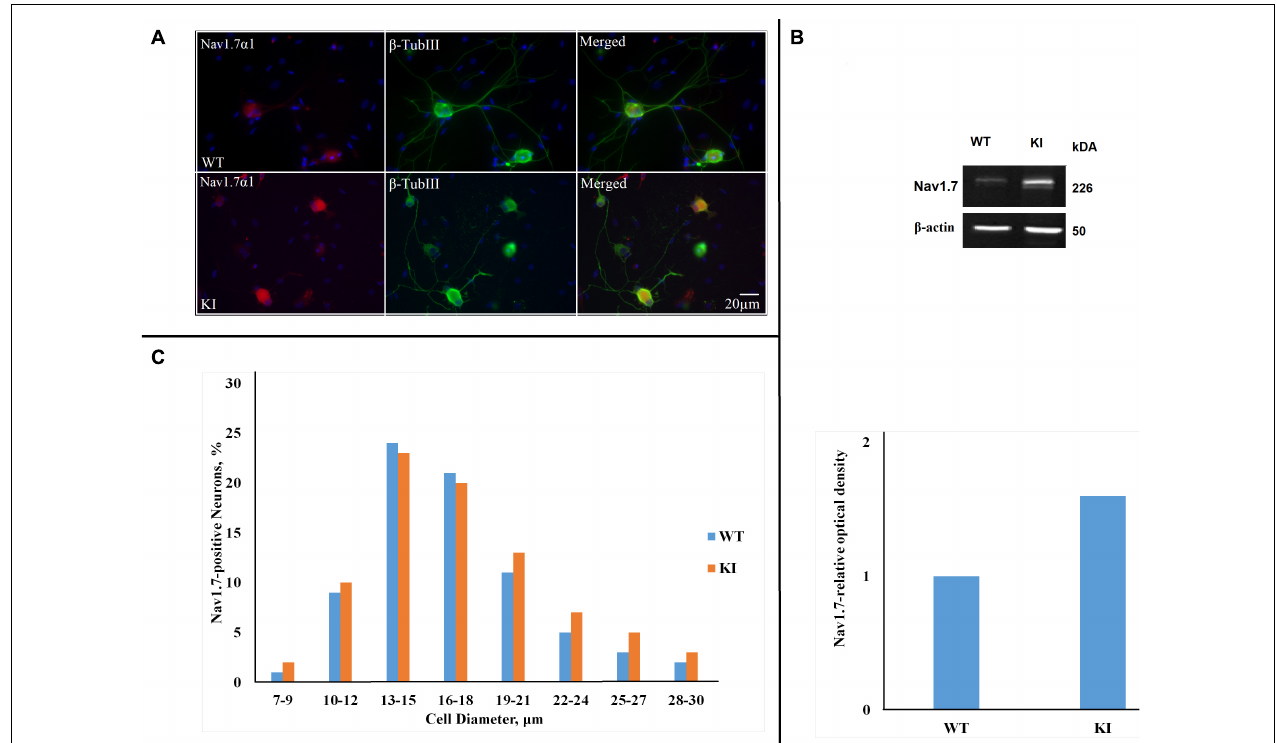
FIGURE 1 | Na V 1.7 α 1 subunit expression in wild-type (WT) and R192Q KI TG cultures. (A) Representative immunofluorescent examples of Na V 1.7 α 1 expression in WT and R192Q KI mouse trigeminal ganglia (TG) cultures. Nuclei are visualized with DAPI (blue); scale bar = 20 µ m. Note extensive co-staining of Na V 1.7 α 1 (red) and β -tubulin III (green) protein in both WT and KI samples. (B) Western blot example showing protein expression of Na V 1.7 α 1 in TG from P12 mice. β -actin was used as a loading control. Histograms representing Na V 1.7 α 1 relative optical density values for each group (* p = 0.46, Mann-Whitney test; n = 8 experiments). Note the significant difference between WT and KI groups. (C) The histograms quantify the cell diameter distribution of Na V 1.7 α 1 immunofluorescence in different subgroups of WT and KI cultures ( n = 3 experiments). The percentages of positive neurons for Na V 1.7 were calculated by considering the total number of neurons labeled by β -Tubulin III as